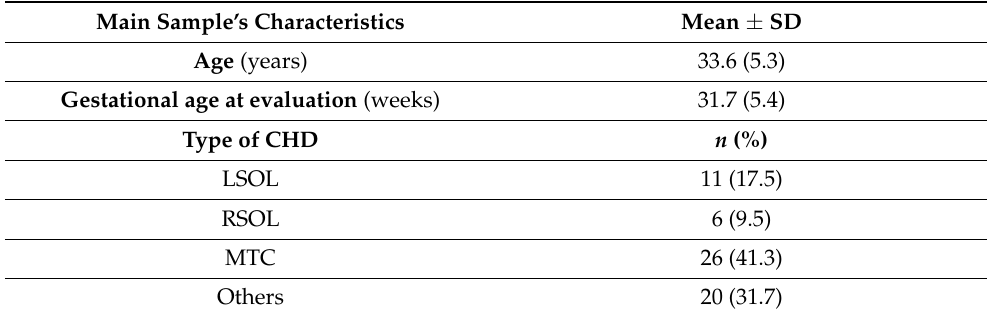
LSOL: left-sided obstructive lesions; RSOL: right-sided obstructive lesions; MTC: mixed type of